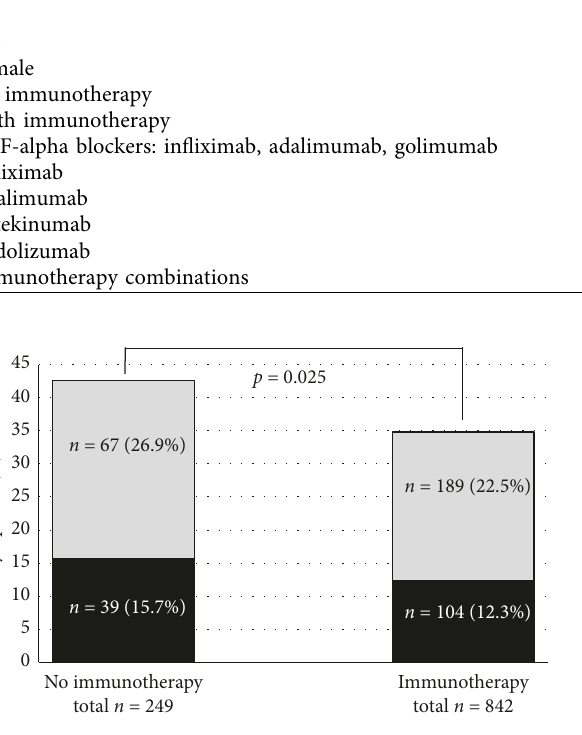
Figure 1: Symptoms of respiratory tract infections: moderate in grey (cough, rhinitis, and sore throat) and severe in black (fever, chills, and anosmia) in patients with or without immunotherapies. Patients with immunotherapies show significant less respiratory symptoms ( p � 0 . 025).